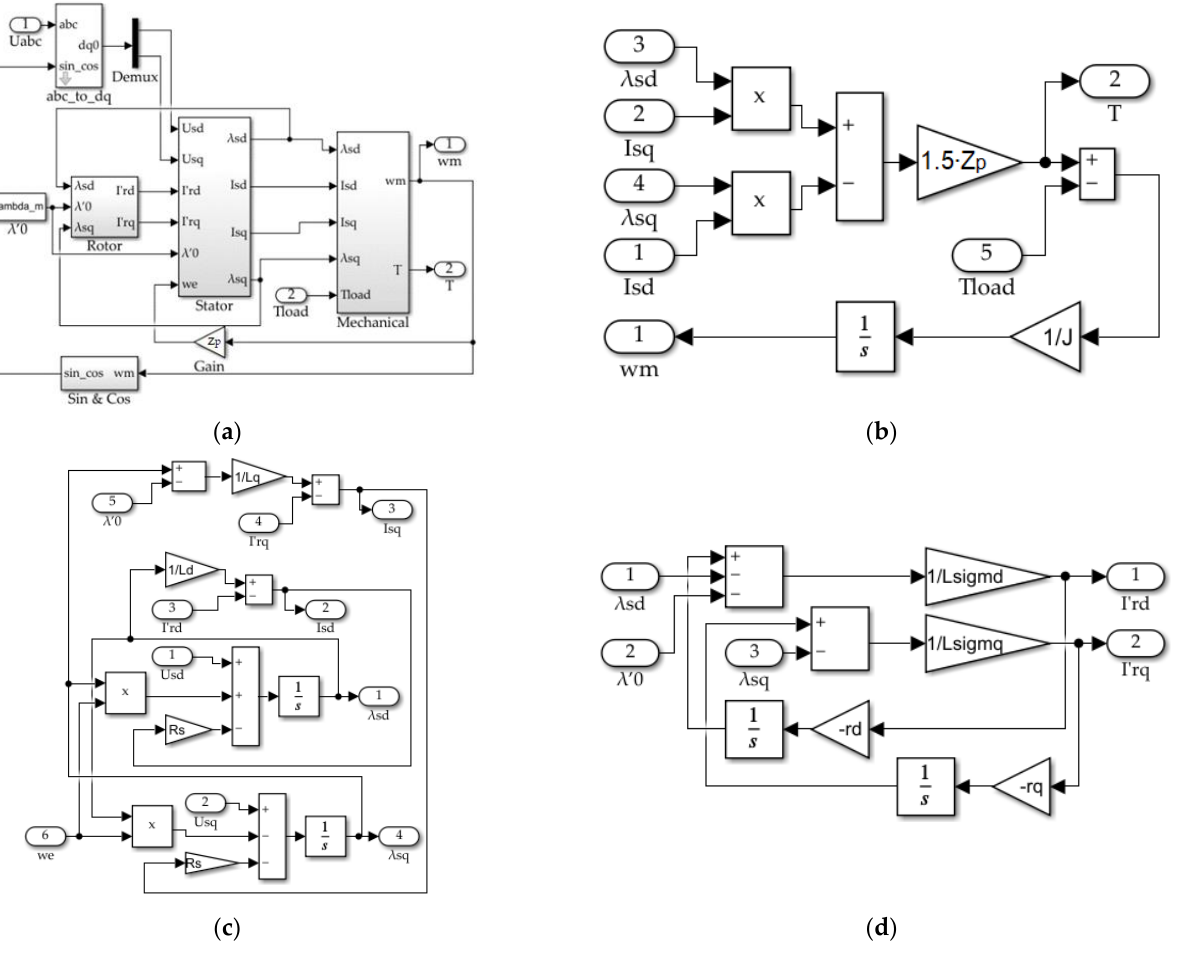
Figure 4. Simulink model of the LSPMSM motor on the d – q -axes: ( a ) General view of the model; ( b ) calculation of the motor torque and angular frequency; ( b ) calculation of stator currents; ( d ) calculation of rotor